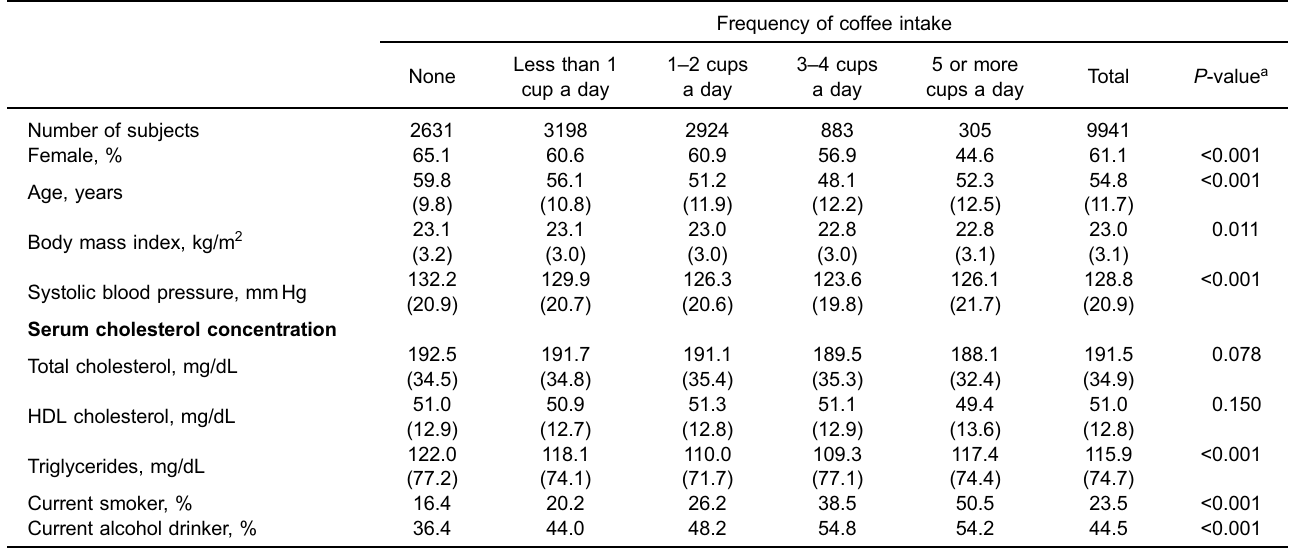
Table 1. Baseline characteristics of participants by frequency of coffee